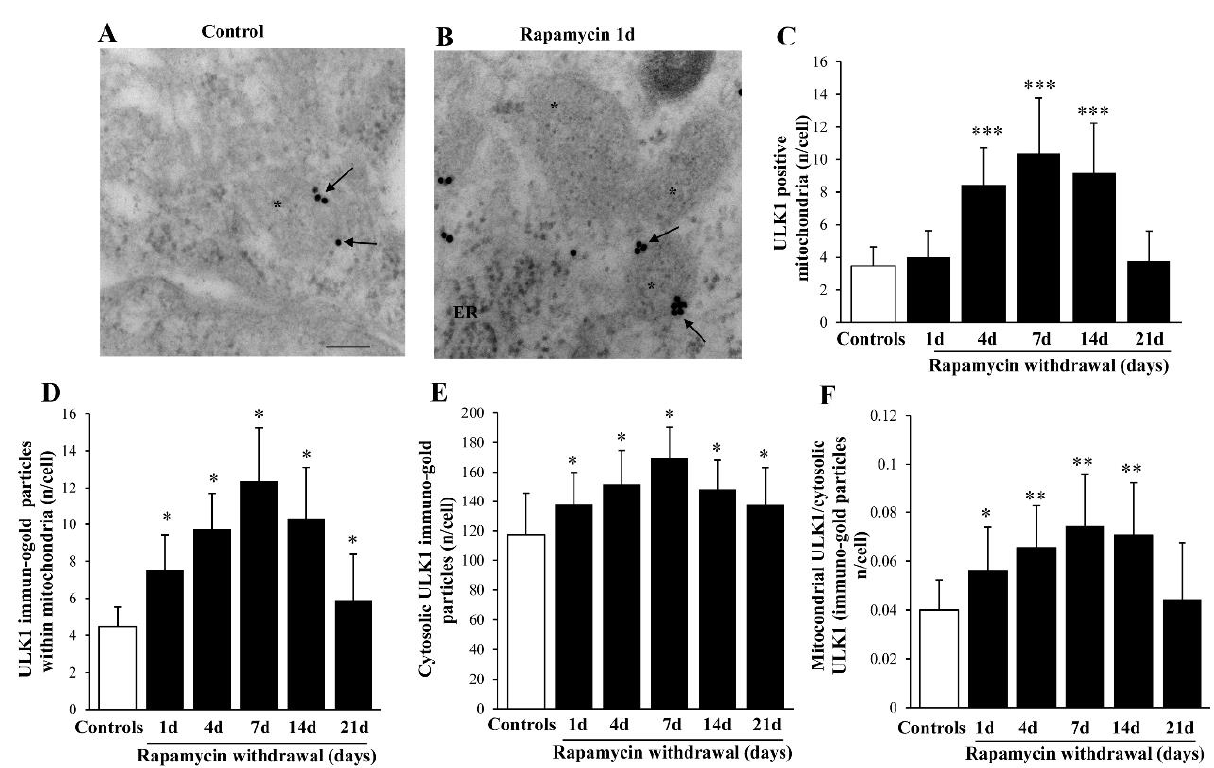
Figure 7. Representative immuno-gold and polarization graphs for the mitophagy marker ULK1. Representative TEM micrograph showing ULK1-positive mitochondria from control ( A ) and following 1 d rapamycin withdrawal ( B ). Arrows point to ULK1 immuno-gold particles within mitochondria. Graphs report the ULK1-positive mitochondria ( C ), ULK1 immuno-gold particles within mitochondria ( D ), the cytosolic amount of ULK1 ( E ), and the ratio of mitochondrial to cytosolic ULK1 particles ( F ). Values reported in the graph correspond to the mean ± SD. Mitochondria were counted in 50 cells per group. * p ≤ 0.05 compared with controls. ** p ≤ 0.05 compared with controls and 21 d. *** p ≤ 0.05 compared with controls, 1 d and 21 d. Scale Bar = 0.2 µ m, Asterisk (*) = mitochondria, ER = endoplasmic reticulum.